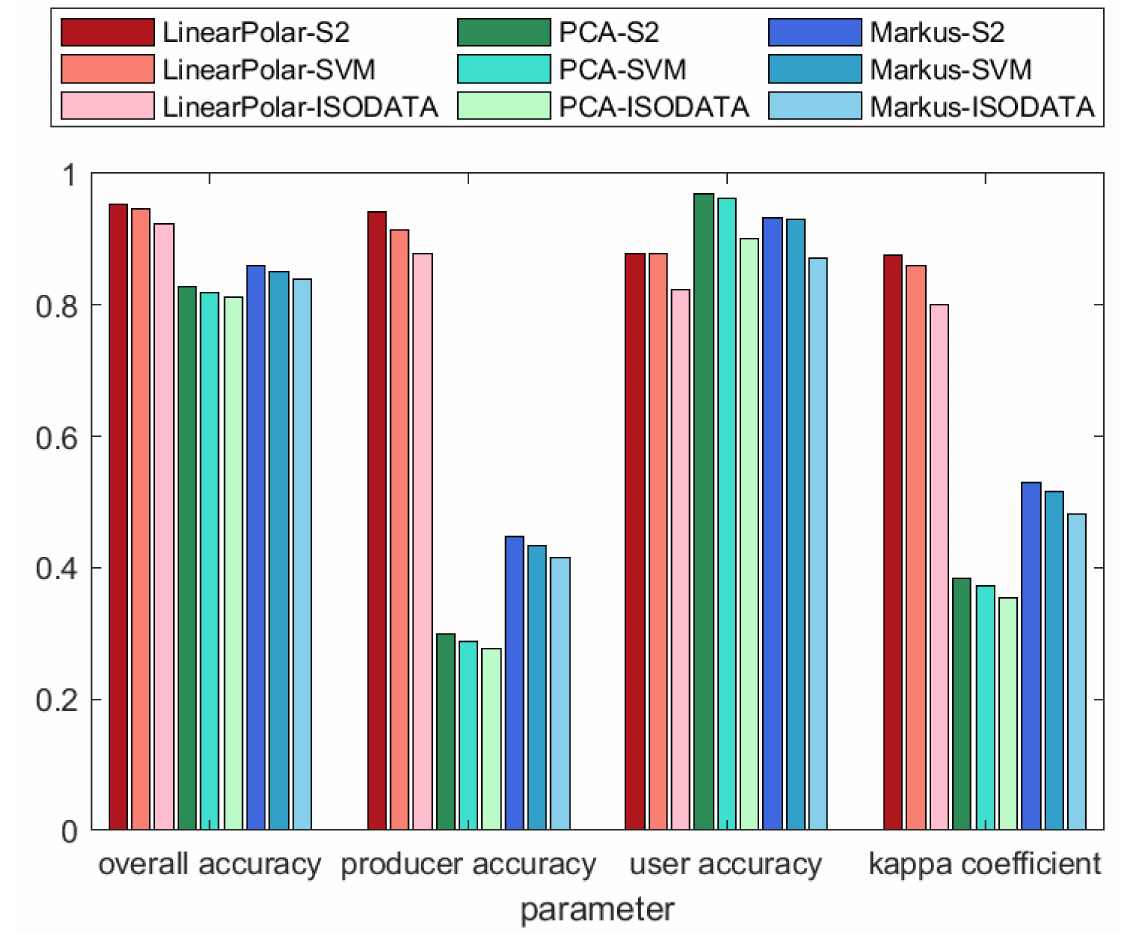
Figure 7. Accuracy of the classification data using 3 algorithms. L8 represents the retrieval result of L8 using the LinearPolar algorithm, PCA represents the retrieval result of L8 using the PCA algorithm, Markus represents the retrieval result of L8 using the Markus algorithm, S2 represents the retrieval result of S2 using the LinearPolar algorithm, SVM represents the classification result of S2 using the SVM algorithm, and ISODATA represents the classification result of S2 using the ISODATA algorithm. A-B represents the accuracy of the results of A, which takes B as the true